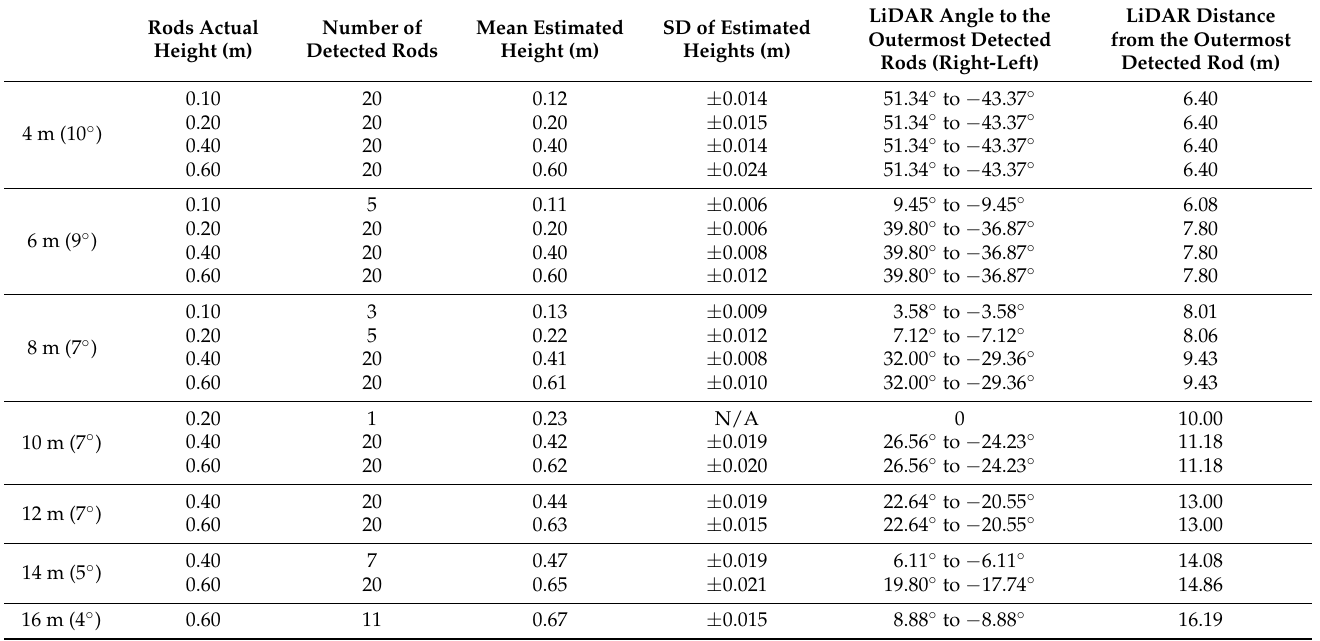
Table 1. Effect of LiDAR distance on detectability and height estimation of a perpendicular line of 20 rods. The LiDAR was 0.70 m above the ground. The LiDAR distance from the middle of the line of rods was 4, 6, 8, 10, 12, 14, 16 m and the LiDAR vertical angle was 10 ◦ , 9 ◦ , 7 ◦ , 7 ◦ , 7 ◦ , 5 ◦ , 4 ◦ ,